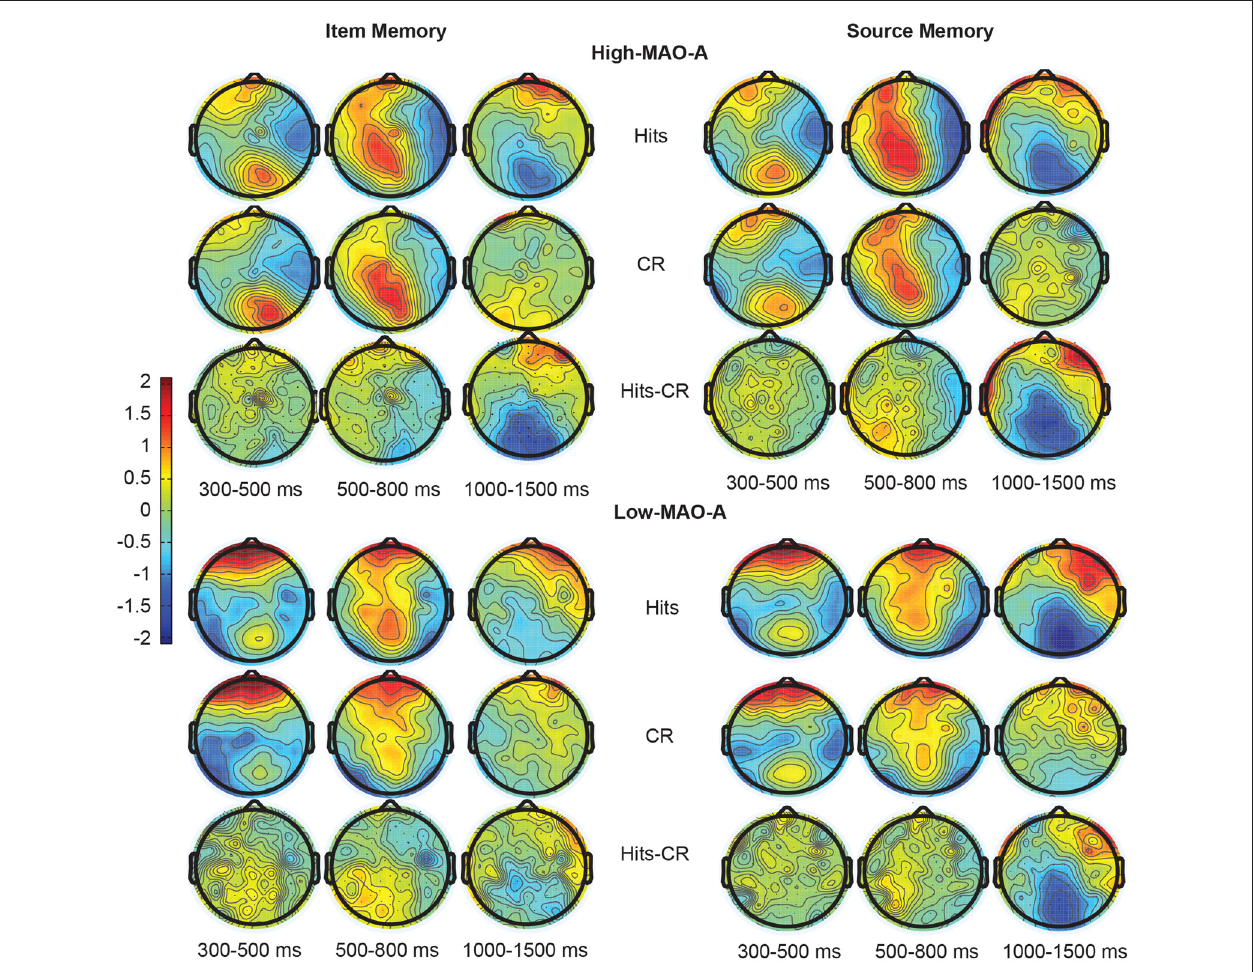
FIGURE 4 | Topographic maps representing the distribution of ERP responses during item (left) and source (right) memory. The top two panels represent ERP responses in the High MAO-A group during Hits (top), correct rejections (CR; middle), and the difference between the hits and CR (bottom) 300–500 ms, 500–800 ms, and 1000–1500 ms post-stimulus presentation. The Low MAO-A group ERP responses are displayed in the bottom two panels with item memory on the left and source memory on the right. Hits for source memory are source hits where the source was correctly